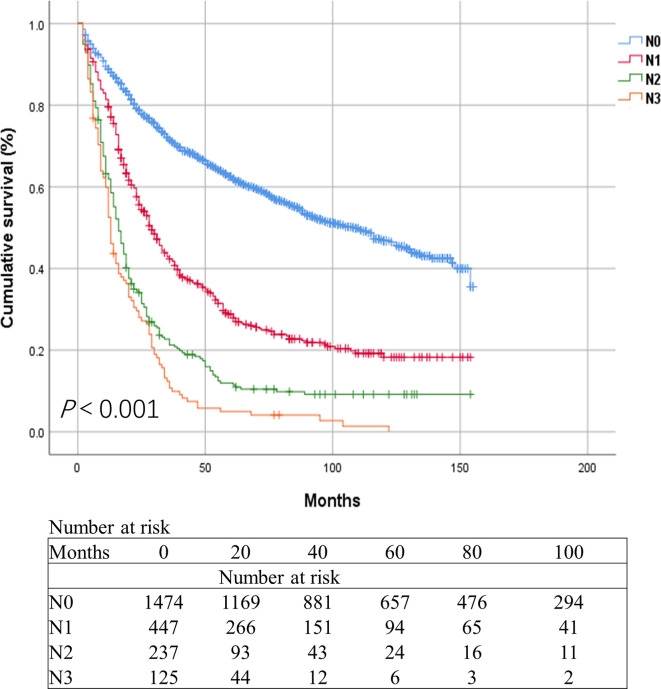
Kaplan-Meier survival curves for esophageal cancer patients in the SEER database based on the current N categories.